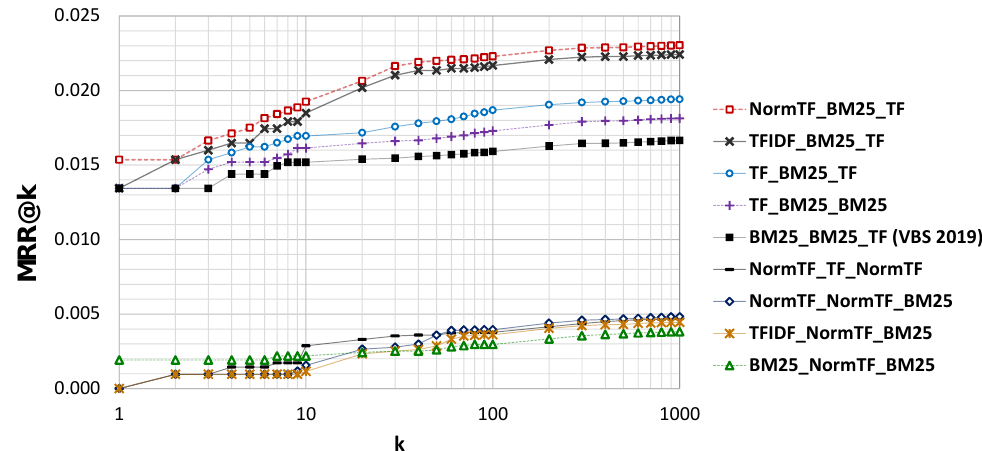
Figure 13. MRR@k for eight combinations of the rankers (the four best, the four worst and the setting used at VBS2019) varying k from 1 to